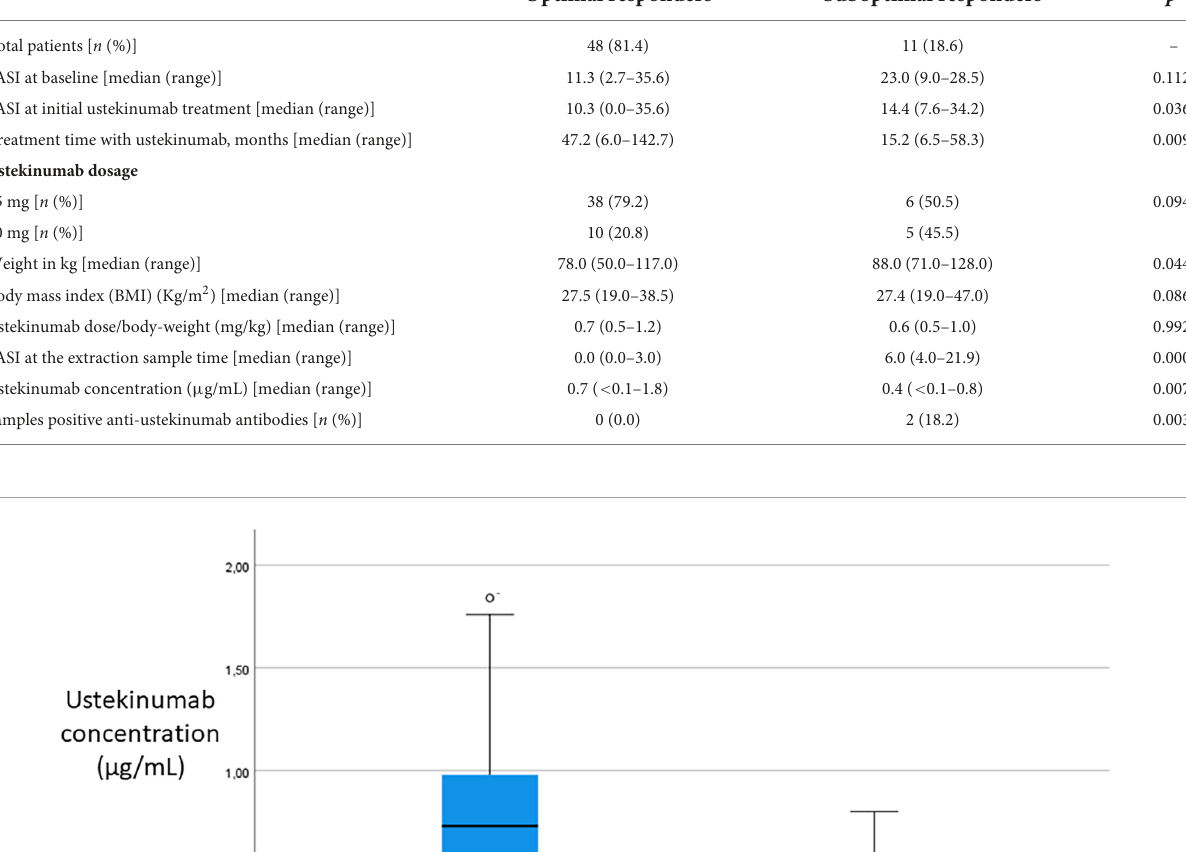
TABLE 2 Clinical characteristics of the two efficacy groups: optimal (PASI ≤ 3) and suboptimal (PASI > 3) responders. Optimal responders